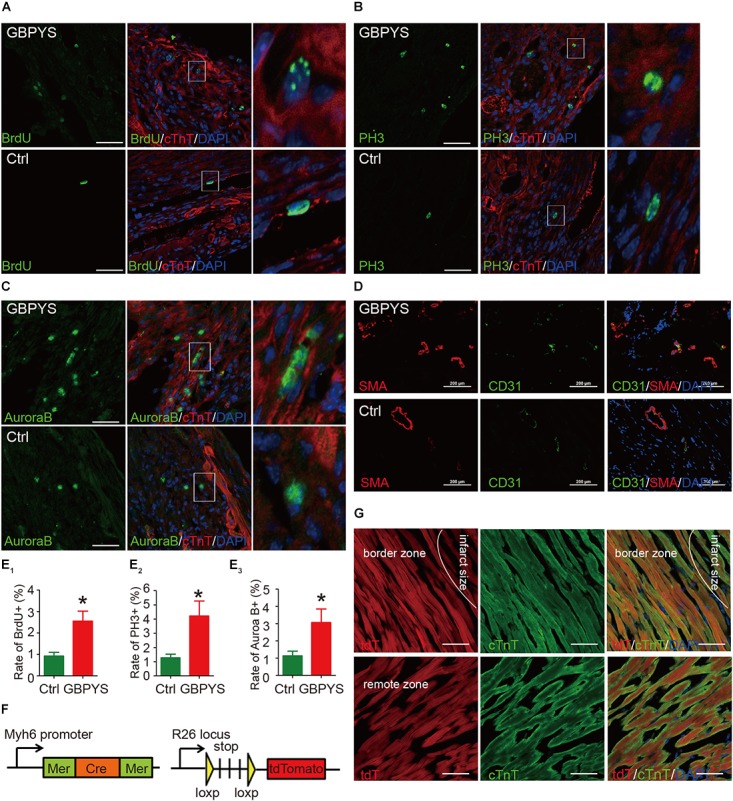
GBPYS feeding induced cardiac proliferation and angiogenesis. (A,B) A significant increase in BrdU (green) incorporation was found in cardiomyocytes from GBPYS-feeding MI mice (n = 6 each). The right image represents the white boxed area in the upper middle image. Scale bars, 100 μm. ∗P < 0.05. (C,D) Co-immunostaining with anti-PH3 (green) and anti-cTnT (red) antibodies of heart tissue sections from MI mice fed with Ctrl or GBPYS feedstuff showed a significant increase in mitosis in cardiomyocytes from GBPYS-fed MI mice (n = 5 for Ctrl, n = 6 for GBPYS). The right image represents the white boxed area in the upper middle image. Scale bar, 100 μm. ∗P < 0.05. (C–E) Co-immunostaining with anti-AuroraB (green) and anti-cTnT (red) antibodies showed a significant increase in cytokinesis in cardiomyocytes from GBPYS-fed MI mice (n = 5 for Ctrl, n = 6 for GBPYS). The right image represents the white boxed area in the upper middle image. Scale bar, 50 μm. ∗P < 0.05. (D) Co-immunostaining with anti-CD31 (green) and anti-smooth muscle actin (red) of heart tissues from MI mice fed with Ctrl or GBPYS feedstuff (n = 3 each). Scale bars, 100 μm. (E) Quantification of ACMs expressing proliferation marker BrdU, PH3, and AuroraB. (F,G) Lineage tracing studies indicated that no newly generated cardiomyocytes were tdTomato-positive. (F) A genetic mouse model of tamoxifen-dependent and cardiomyocyte-specific irreversible labeling with fluorescent protein tdTomato. (G) Immunostaining of cardiomyocytes (cTnT) and tdTomato in the border zone and remote zone of hearts from GBPYS-feeding mice with MI. Scale bars, 50 μm.